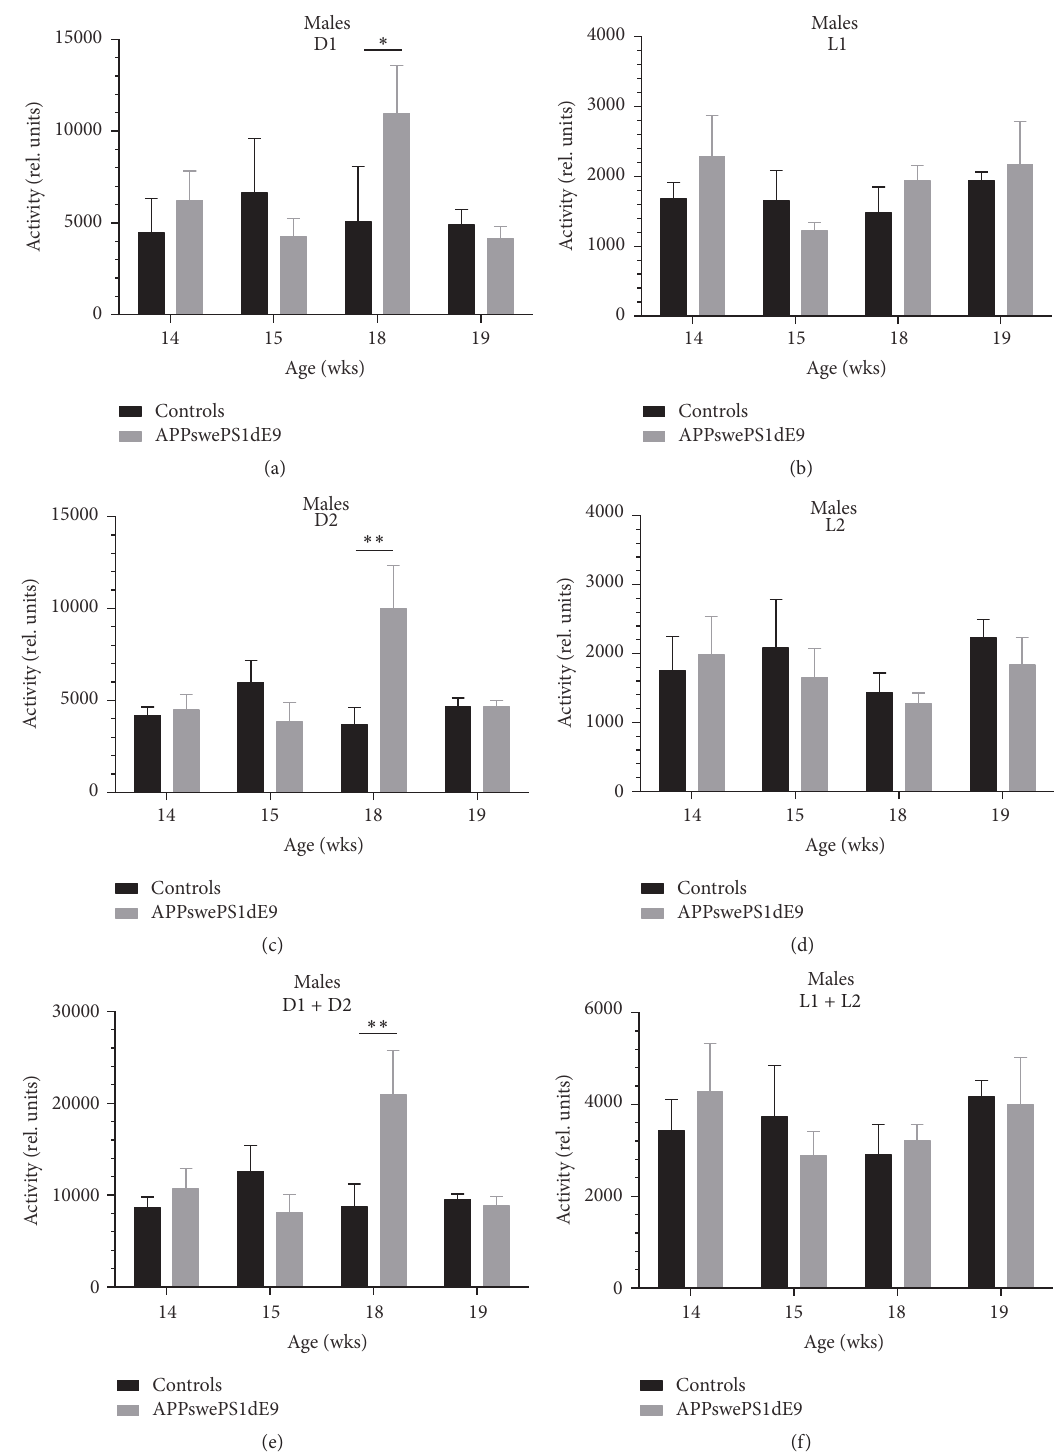
Figure 2: Activity analysis in controls and APPswePS1dE9 mice. Animals from both groups were analyzed for motor activity (relative units) fordifferentages(14,15,18,and19 wks)andcircadianperiods(D1,L1,D2,L2,D1+D2,andL1+L2).MaleAlzheimermiceexhibitedsignificant increase in relative activity compared to controls at the age of 18wks during the dark cyle(s) (D1, D2, and D1 + D1). In females, no changes were observed in motor activity (see Supplementary Figure 1). ∗ 𝑝 < 0.05 . ∗∗ 𝑝 < 0.01